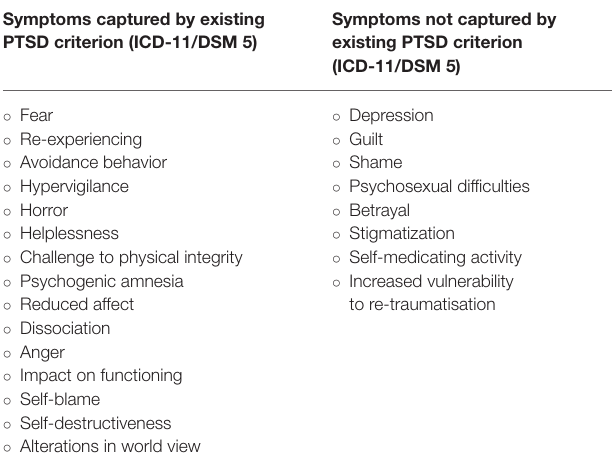
TABLE 1 | Symptom capture and limitations on existing PTSD